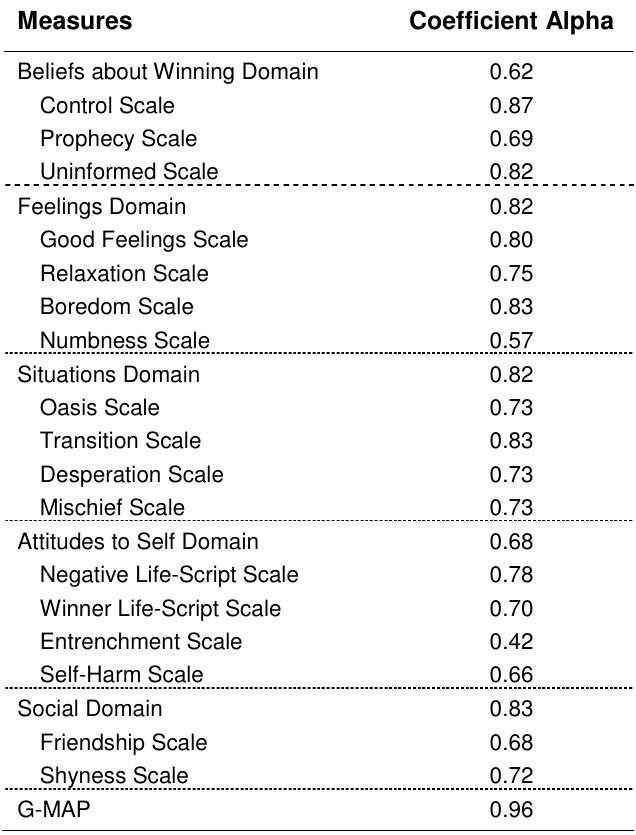
Coefficient Alpha and Mean Item-Item Correlation Coefficient for the G-MAP Domains and